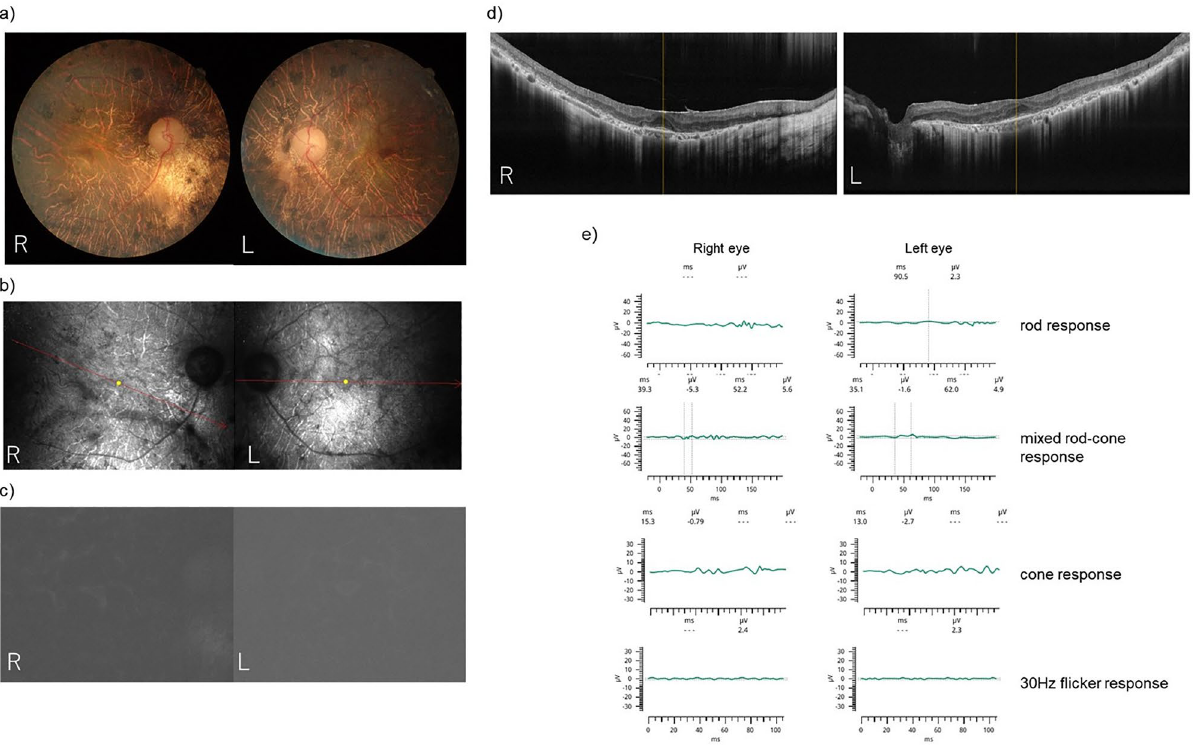
Figure 3. Retinitis pigmentosa phenotype of the proband at 68 years old. ( a ) Color images; ( b ) red free images; ( c ) autofluorescence images; ( d ) macula section with Optical coherence tomography; ( e ) Electroretinography